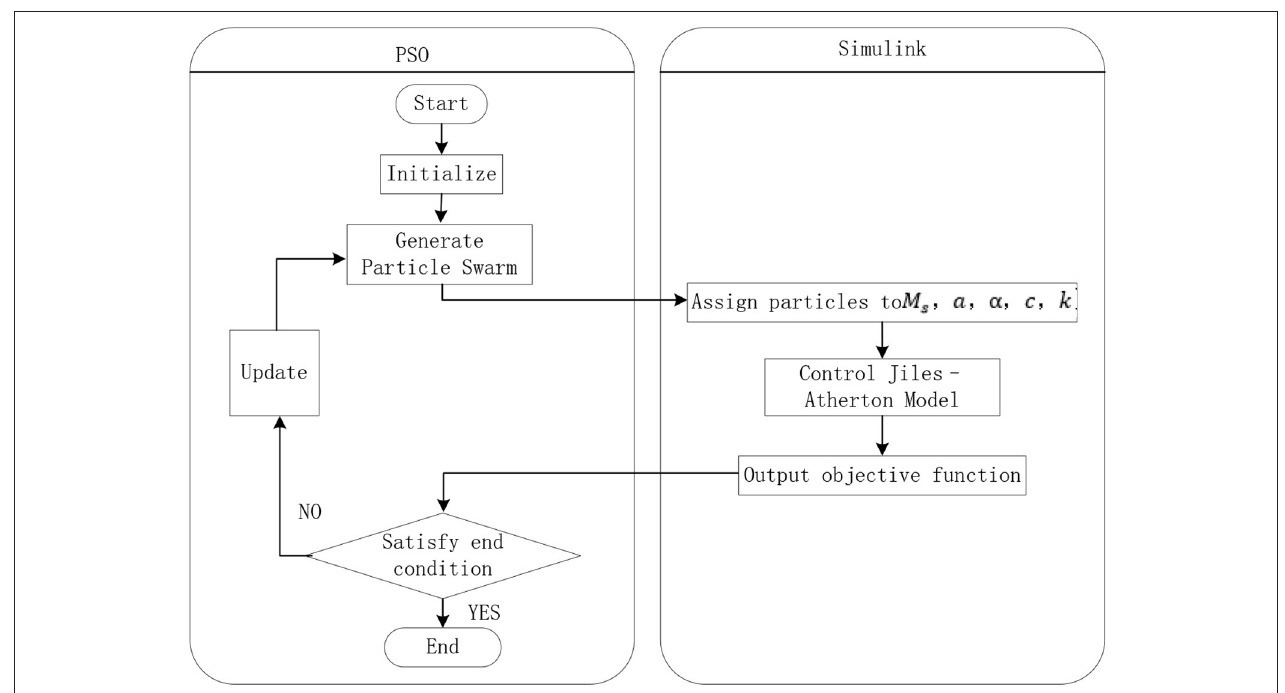
FIGURE 7 | Flow diagram of parameters optimization of Jiles-Atherton model using PSO.